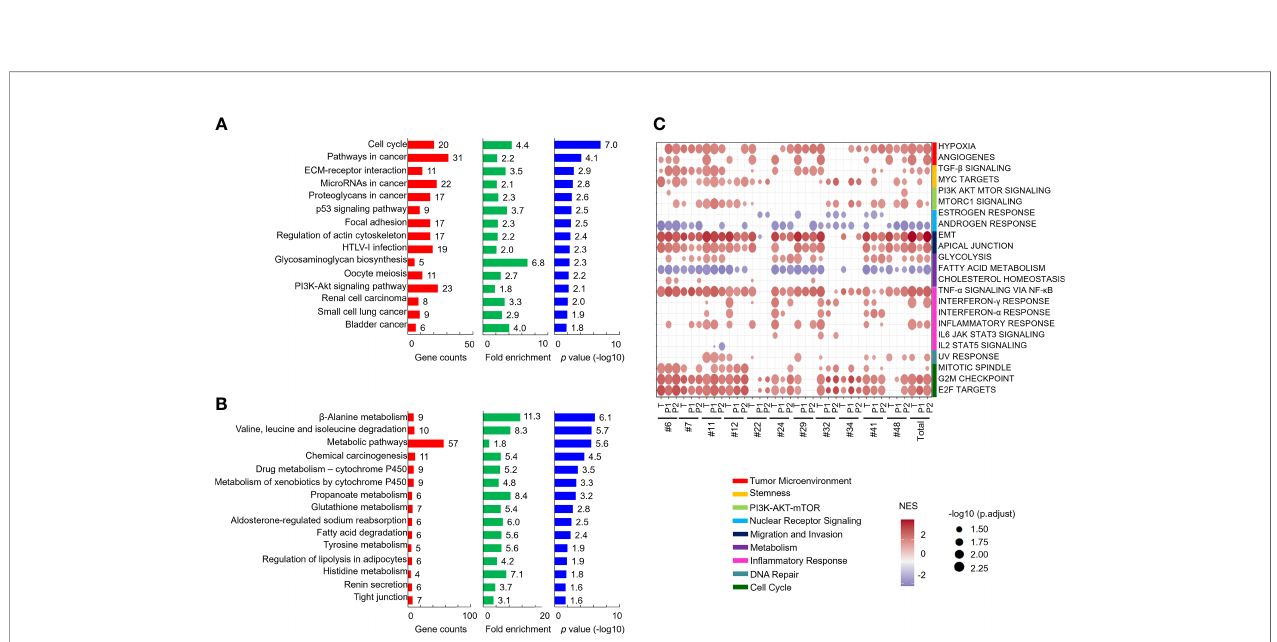
FIGURE 6 | Comparison of the similar pathways in patients and their PDXs. Genes with a 2-fold change and p < 0.05 in both patient tumor tissues and PDXs compared with patient adjacent normal tissues were subjected to KEGG pathway analysis. The results of the pathway analysis are summarized by bar charts and show the gene counts, fold enrichment, and -log p value. The pathways are labeled along the y-axis. The upregulated (A) and downregulated (B) genes were subjected to pathway annotation. Enriched cancer hallmarks in paired OSCC patients and xenografts were shown in (C)